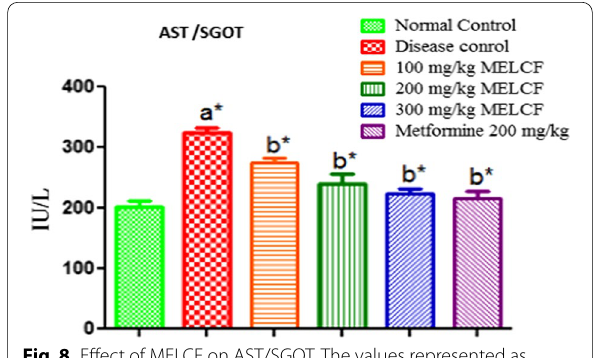
Fig. 8 Effect of MELCF on AST/SGOT. The values represented as mean SEM ( n 6). a* ( p < 0.05) when compared to normal control ± = and b* ( p < 0.05) when compared to disease/diabetic control